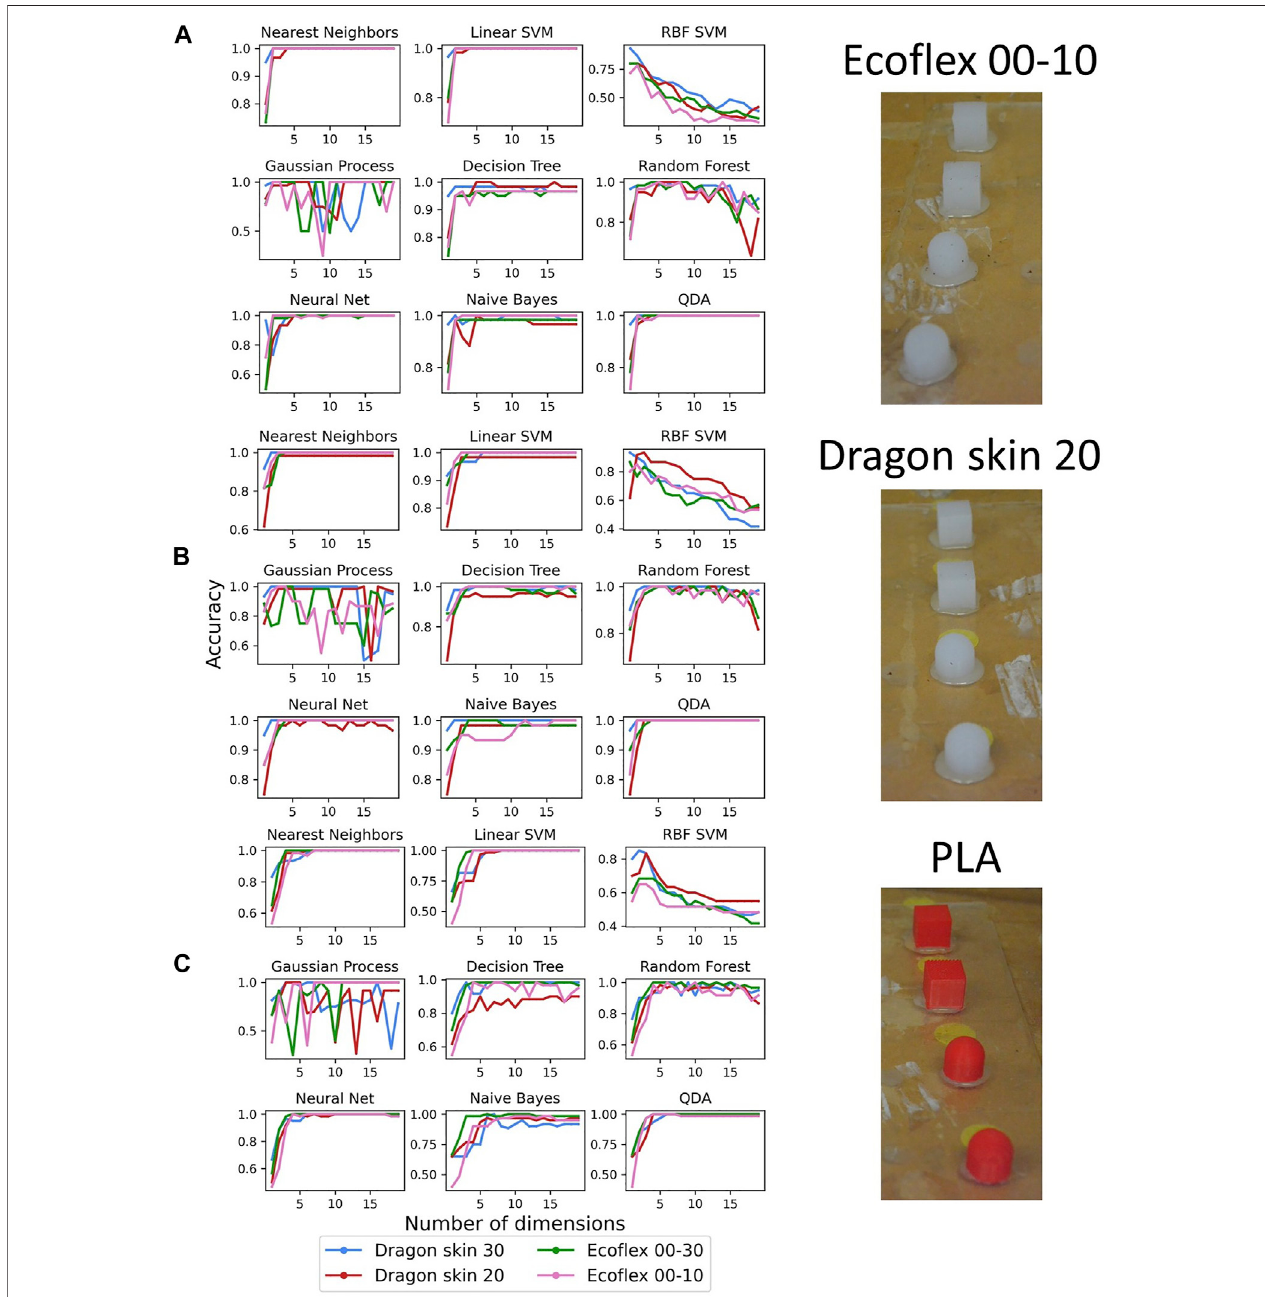
FIGURE 11 | Classi fi cation accuracy results when testing the fi lter ’ s material on the three different subsets made by test objects of the same material: Eco fl ex 00 – 10 (A) , Dragon Skin 20 (B) , and PLA (C) .